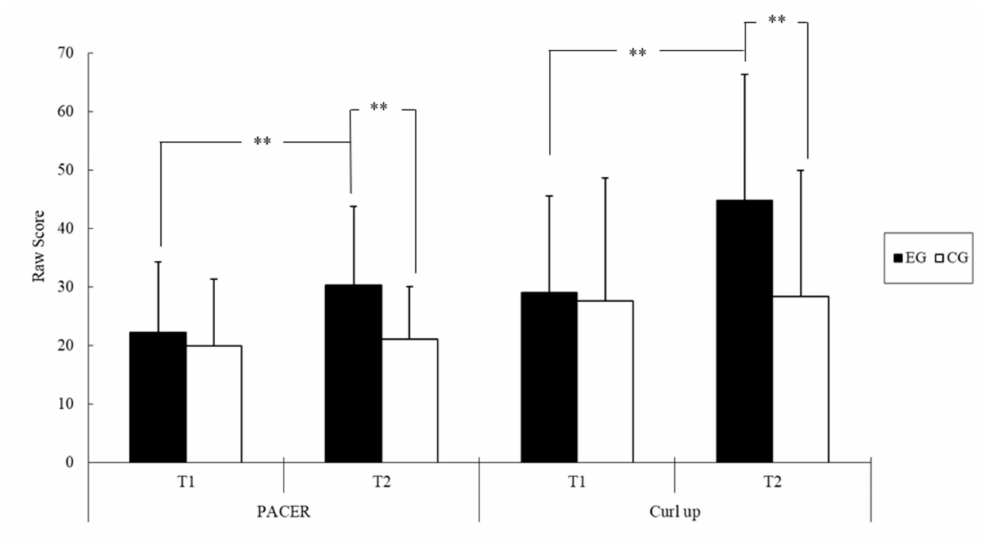
Figure 2. The physical fitness score of two groups of youths with IDs before (T1) and after the intervention (T2); ** p < 0.01 (Abbreviations: PACER = Progressive Aerobic Cardiovascular Endurance Run; EG = exercise group; CG = control